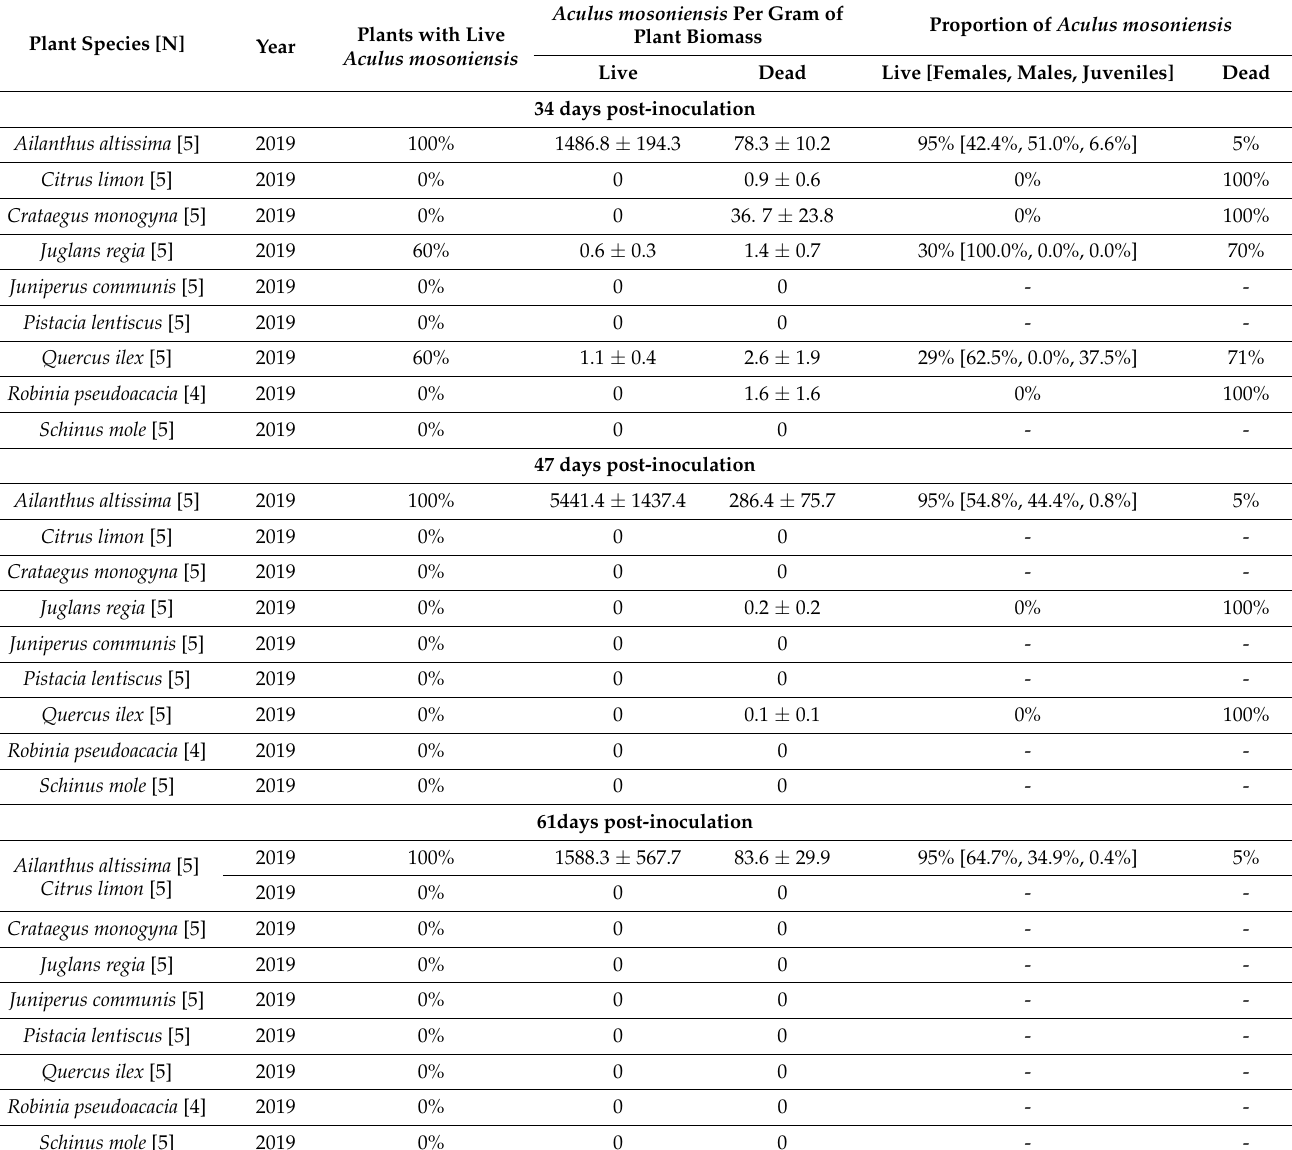
Table A1. Number of replicates for each plant species [N]; percentage of plants infested with live Aculus mosoniensis ; number of live and dead A. mosoniensis per gram of plant biomass (mean ± SE) collected from each plant species tested; proportion of live and dead A. mosoniensis , and of adult females and males, and juveniles among the live A. mosoniensis collected from each plant species tested, at different sampling dates (i.e., 34, 47, and 61 days post-inoculation, respectively) in 2019.